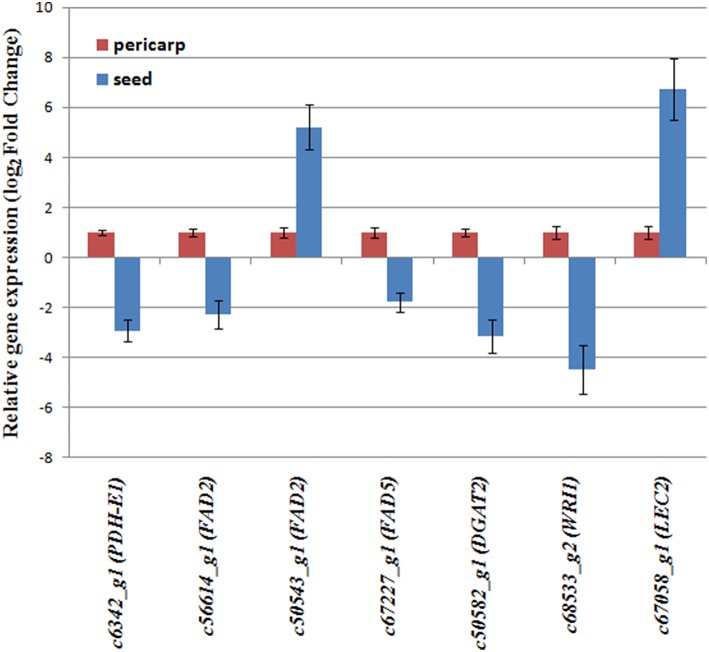
qRT-PCR verification of selected differentially expressed genes. Gene expression in the seed and pericarp at 60 DAP was examined with a StepOnePlus™ Real-Time PCR Systems (Applied Biosystems) using SYBR Premix ExTaq™ (TaKaRa) according to the manufacturer's protocol. Relative expression values were calculated using the 2−ΔΔCt method by using EF1A gene as an internal control and were given as mean of the normalized expression levels of three replicates. For comparison, the gene expression level in the pericarp was arbitrarily set as 1.